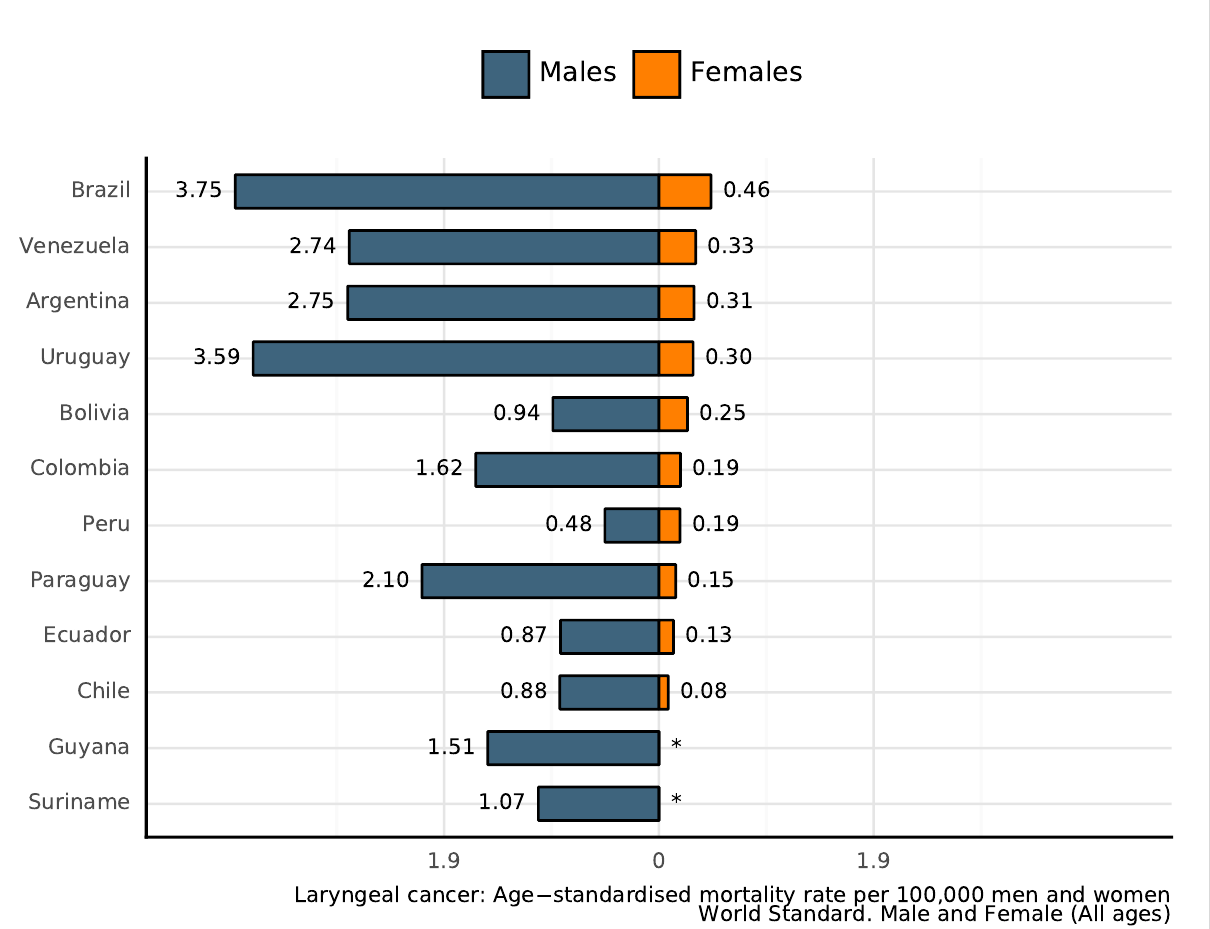
Figure 132: Age-standardised mortality rates of laryngeal cancer of Peru (estimates for 2020)